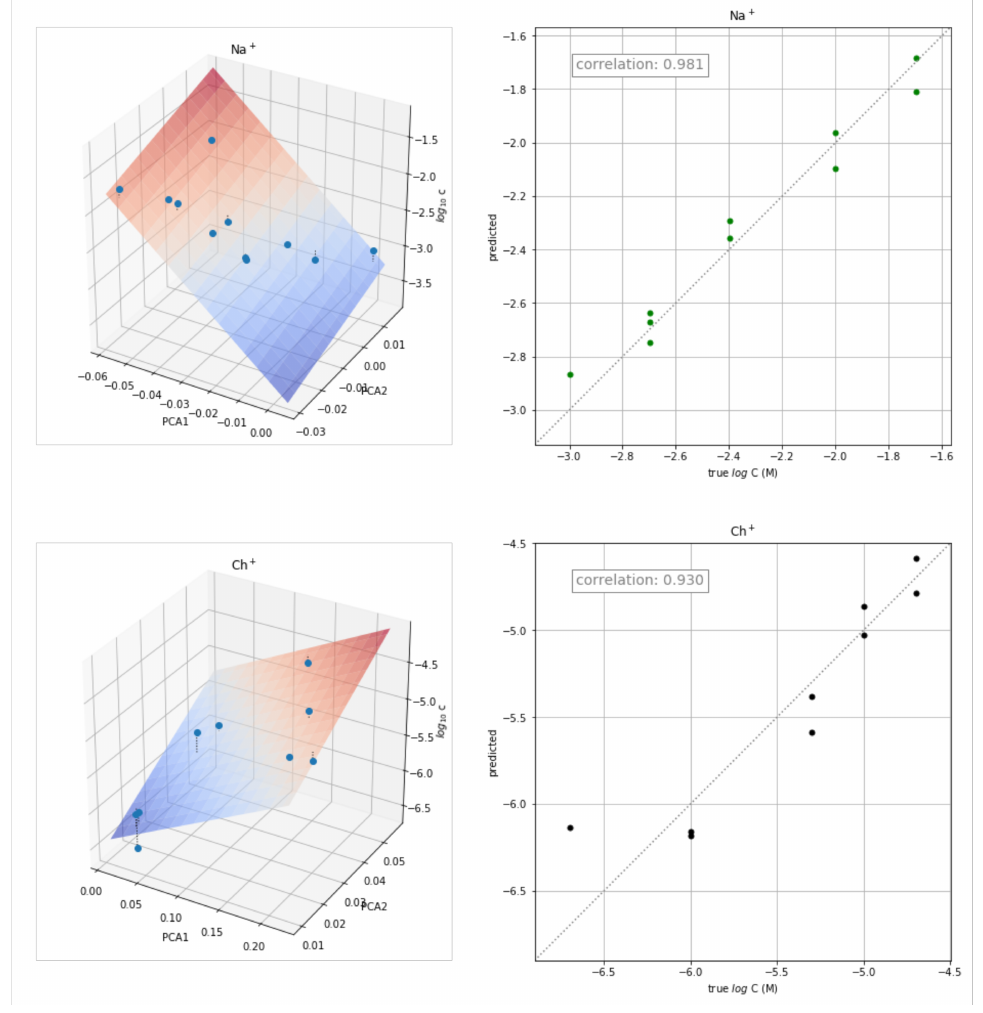
Figure 6. Three-dimensional plots PC1 and PC2 scores versus log C ( left ) and plots of the concentra- tion values predicted versus the actual values ( right ) for K + , Rb + , Na + , and Ch +